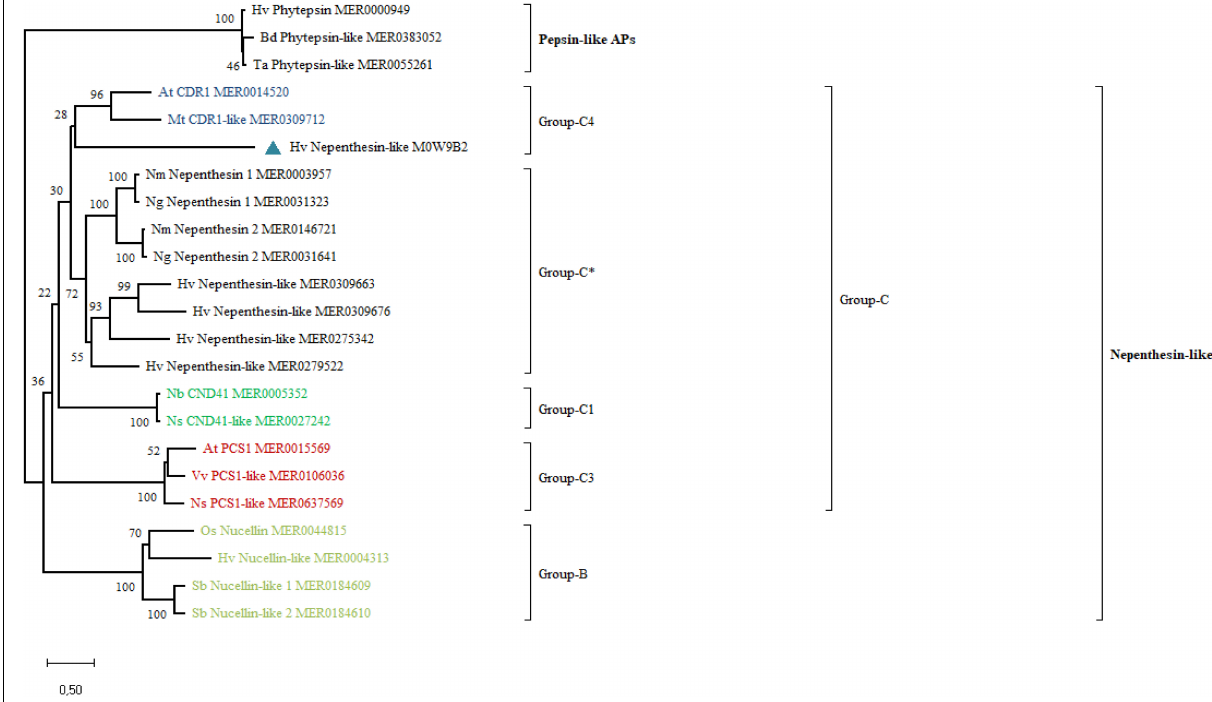
FIGURE 2 | Phylogenetic analysis of HvNEP-1 and related nepenthesin-like activator proteins (APs) from various plant species. Percentage bootstrap values from 1,000 replicates are indicated at each node. The scale (0.50) represents the number of amino acid substitutions per site. Plant species included in the tree are At, Arabidopsis thaliana ; Bd, Brachypodium distachyon ; Hv, Hordeum vulgare ; Mt, Medicago truncatula ; Nb, Nictotiana benthamiana ; Ng, Nepenthes gracilis ; Nm, Nepenthes mirabilis ; Ns, Nicotiana sylvestris ; Os, Oryza sativa ; Sb, Sorghum bicolor ; Ta, Triticum aestivum ; Vv, Vitis vinifera. MEROPS or UniProt identifiers are indicated on the tree. ∗ represents the most common nepenthesin